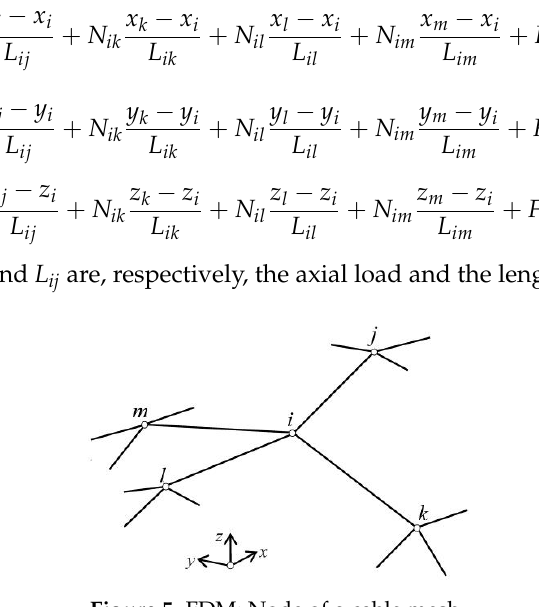
Figure 5. FDM: Node of a cable mesh.